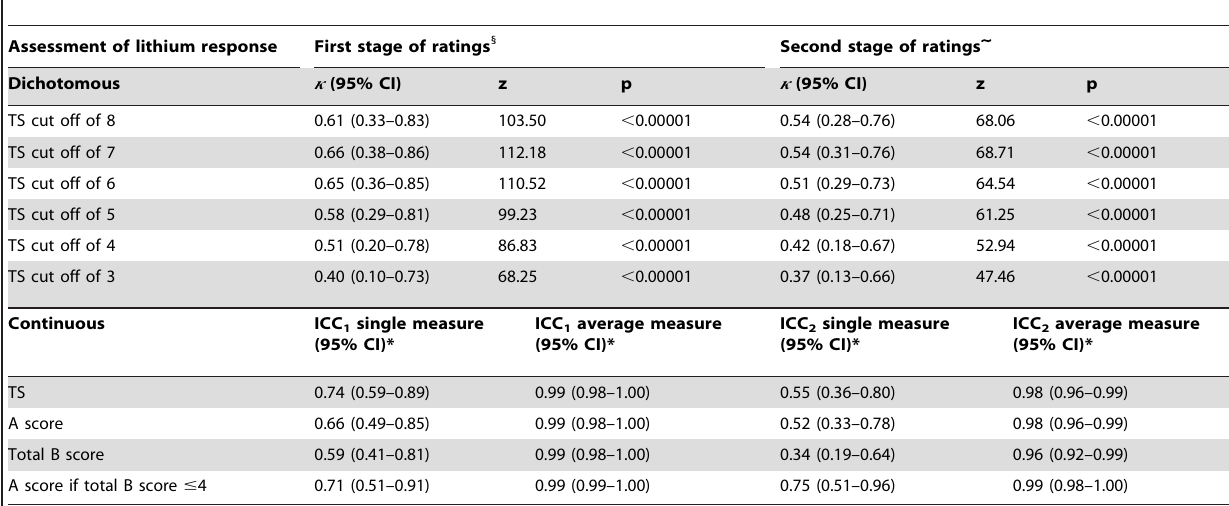
Table 2. Inter-rater agreement and reliability of the assessment of lithium response in the two-stage case-vignette rating procedure: kappa and intra-class correlation analysis.